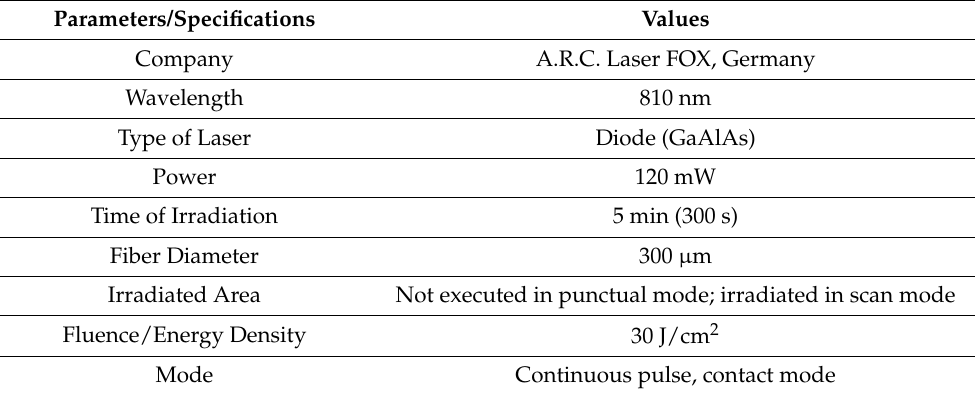
Table 1. Laser parameters used in this